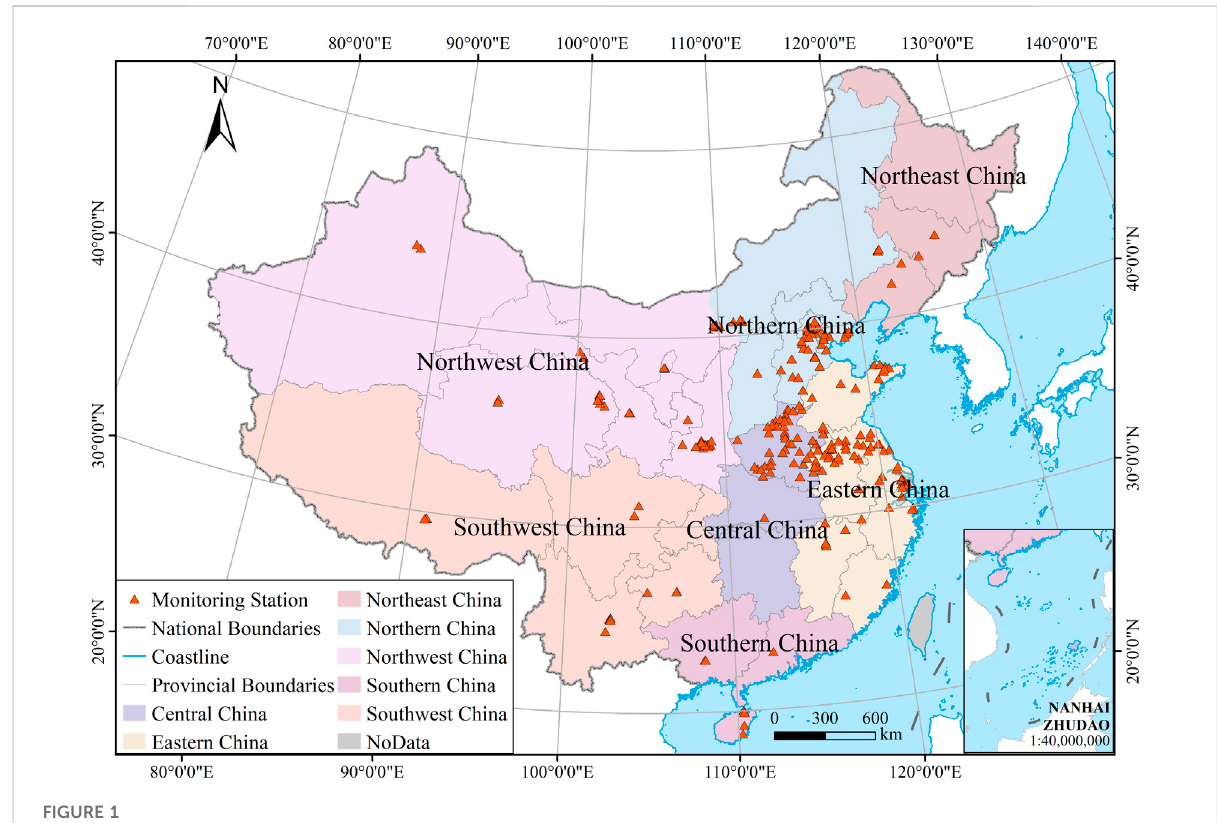
FIGURE 1 Geographical regions in China included in this